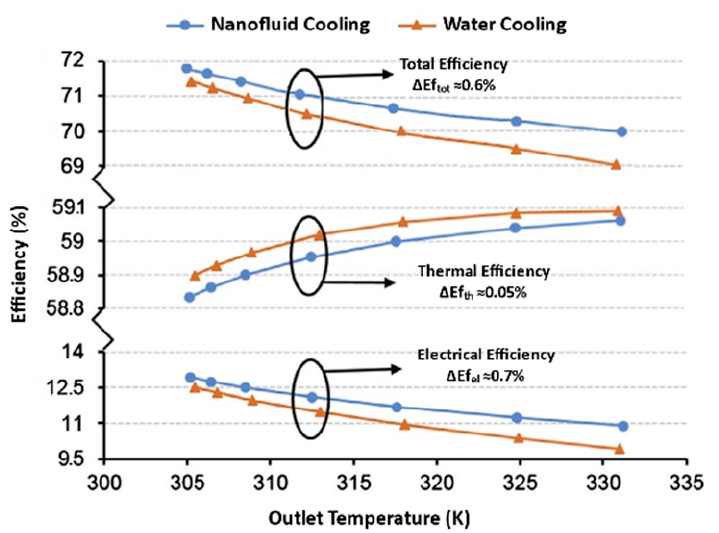
Figure 7. Evolution of the CPVT efficiency as a function of the outer temperature of the two heat transfer fluids under study (adapted from [18]).